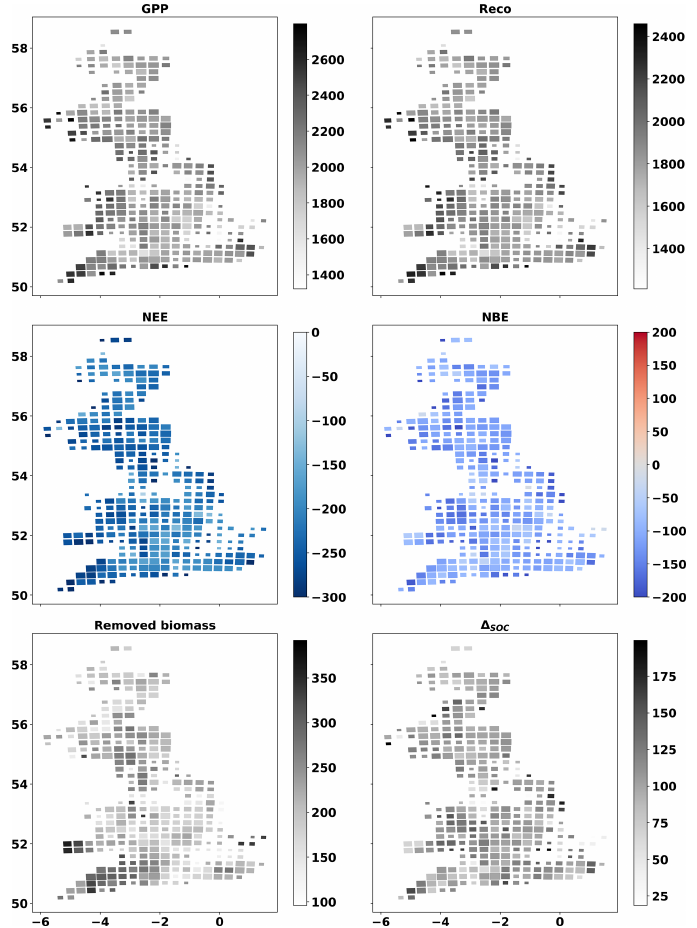
Figure A5. Cartograms of MDF-predicted GPP, Reco, NEE, NBE, removed biomass and C flux to SOC. The mean value for 2017–2018 across all fields in each cell is presented. The size of cells is adjusted according to the number of simulated fields within it. Unit: gCm − 2 yr − 1